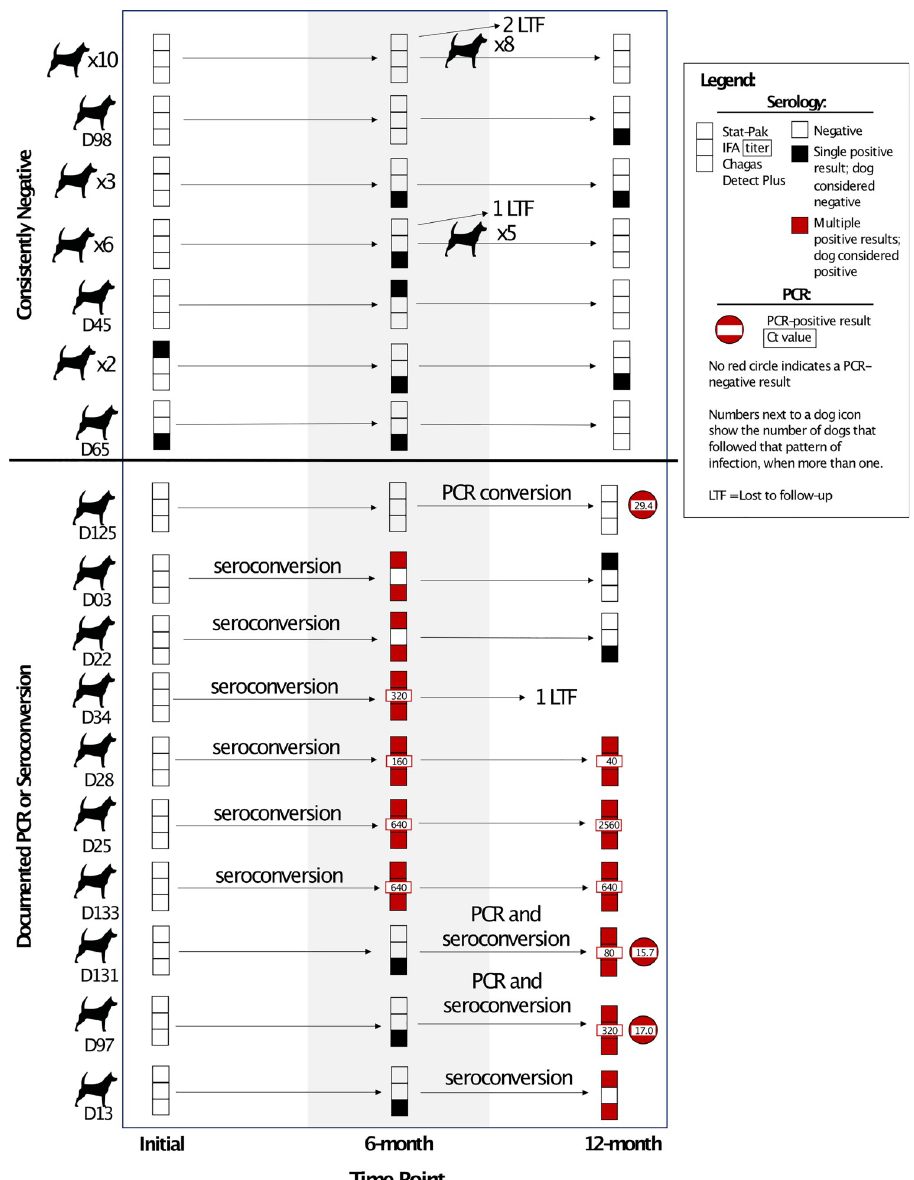
Fig 1. Serology and PCR results of all dogs enrolled as T . cruzi- negative (n = 34) at each sampling time point. Dogs are organized by those that remained negative above the black horizontal line and those that had a documented PCR or seroconversion during the study below the line. When multiple dogs had the same progression of test results, this progression is depicted as a single row in the figure with the number of dogs shown on the left side of the figure. Changes in serostatus or PCR status are written between time points in which the conversion took place. The titer for positive IFA tests and the Ct value for PCR-positive tests are noted in the respective